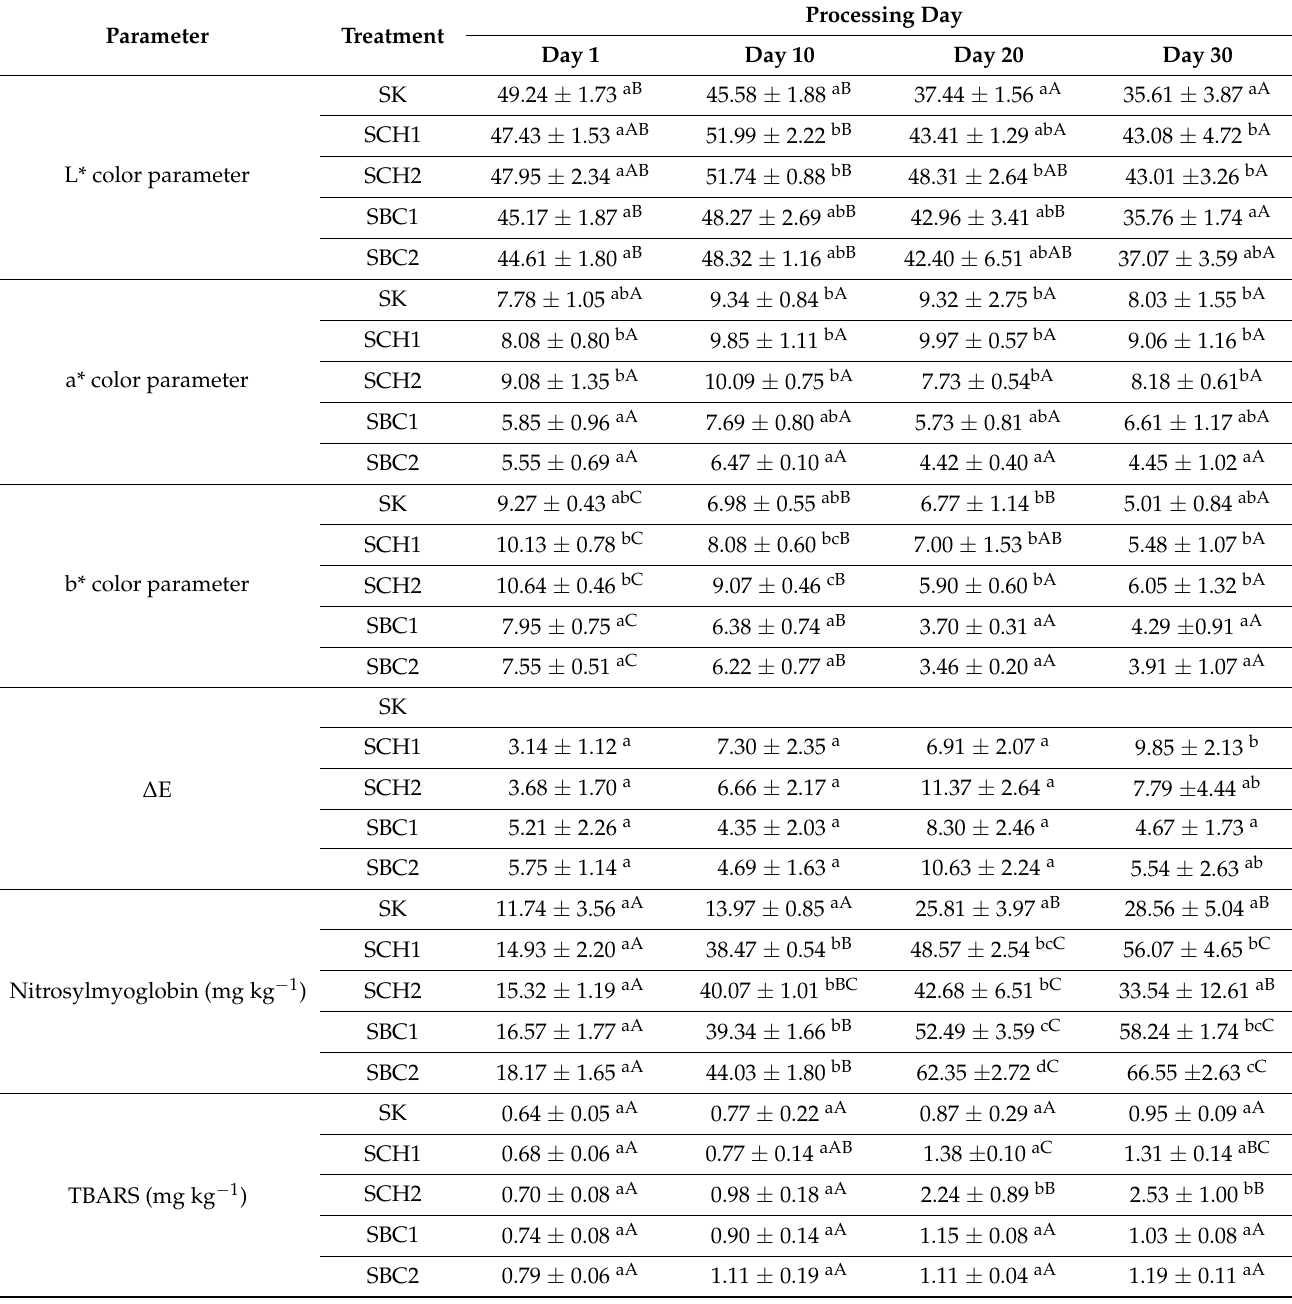
Table 2. The evolution of color parameters, nitrosylmyoglobin, and TBARS content during the manufacturing process of dry fermented